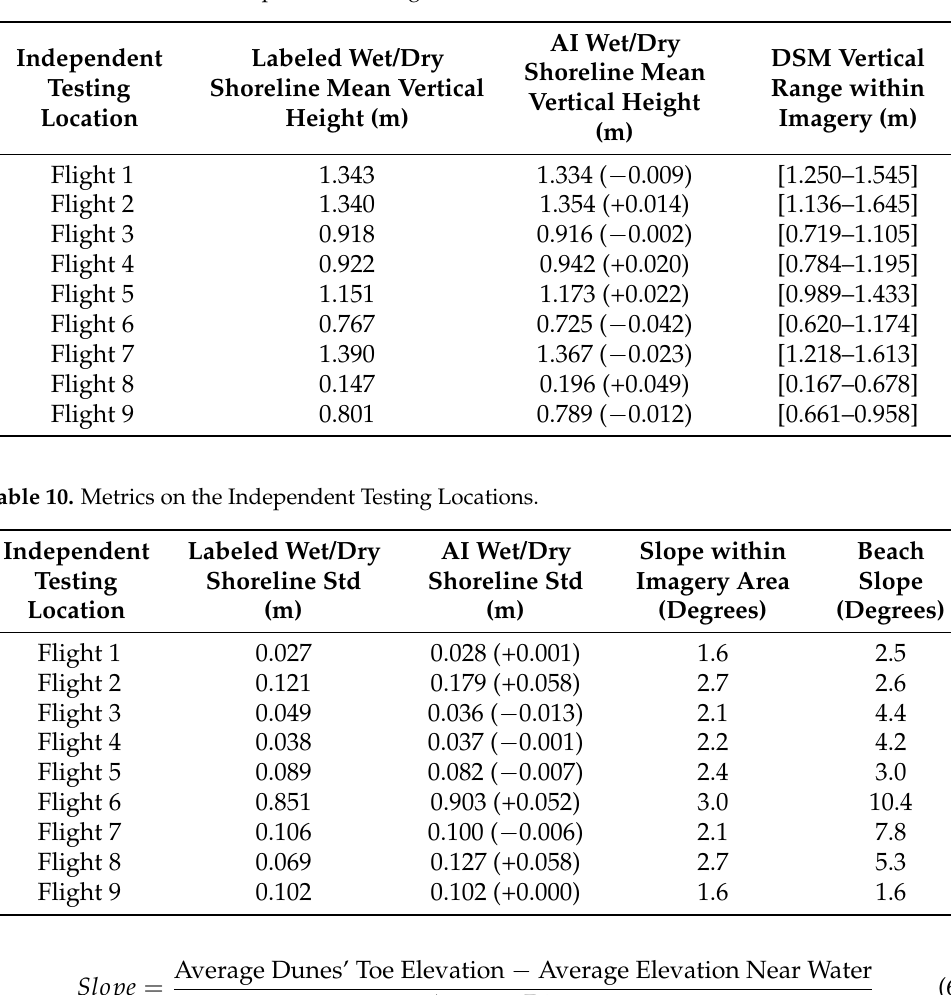
Table 9. Metrics on the Independent Testing Locations.